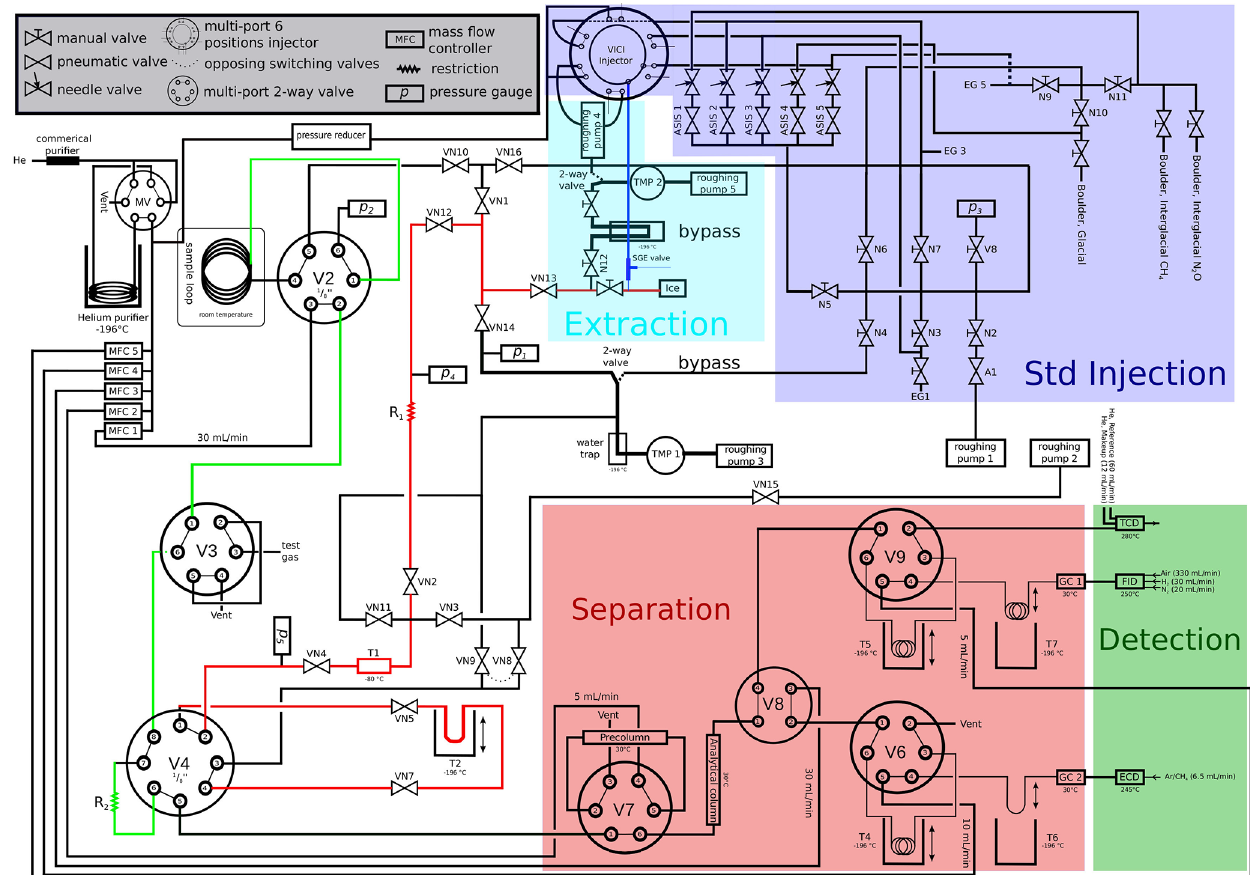
Figure A1. Flow scheme of the CH 4 and N 2 O measurement system. The red, green, and blue paths highlight the ice line (IL), continuous- flow line (CFL), and standard over ice line (SOIL), respectively. Coloured boxes display the different functional units of the system discussed in Appendix